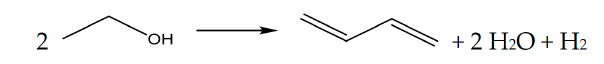
Figure 2. Stoichiometry of the ethanol-to-butadiene reaction.